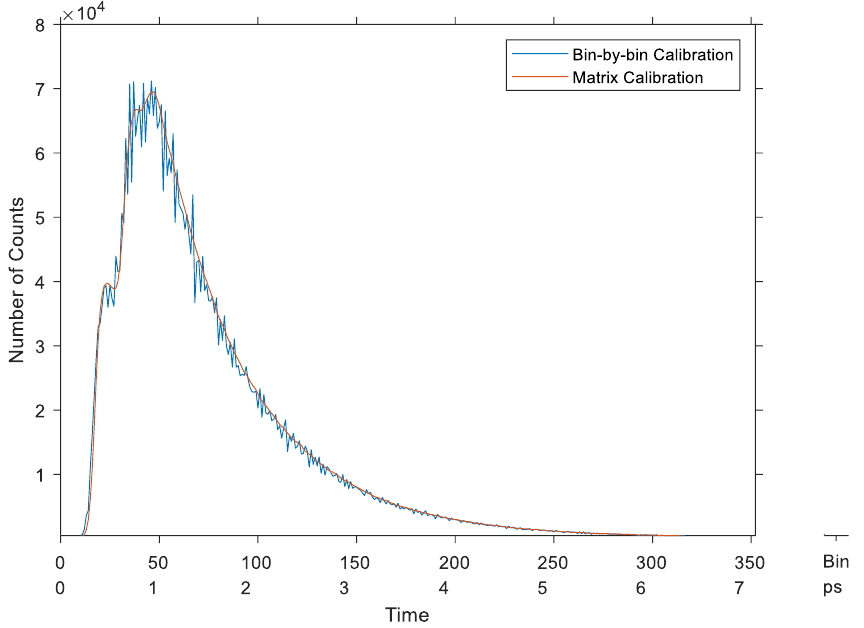
Figure 19. Fluorescence signal of a piece of paper using the two calibration methods — Asynchronous TDC.